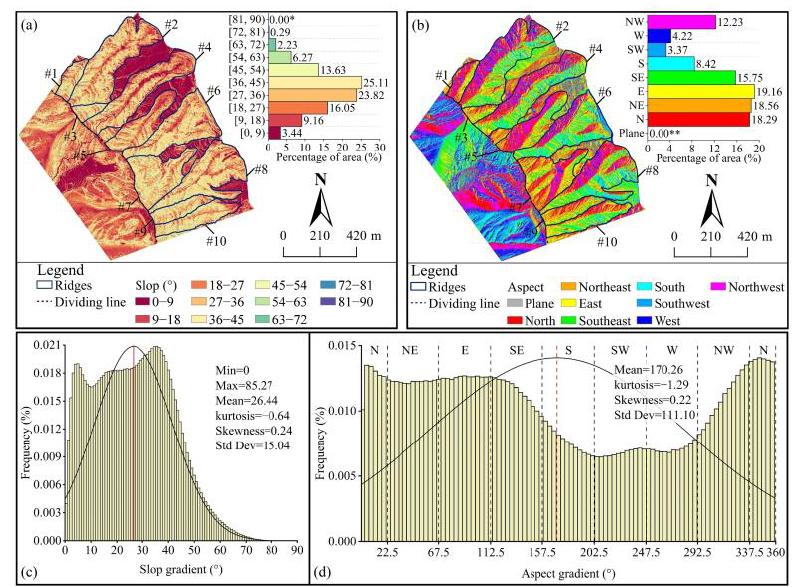
Figure 13. ( a ) Slope reclassification results, ( b ) aspect analysis results, ( c ) slope frequency statistics, and ( d ) aspect frequency statistics (* 0.0007181, ** 0.0001323).